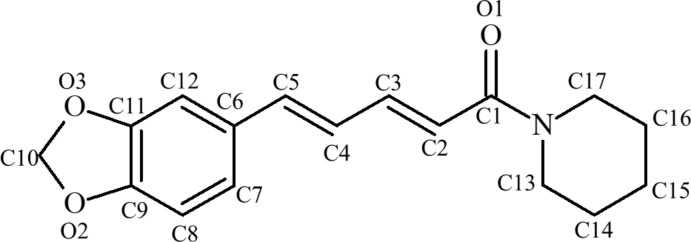
The chemical structure of piperine.